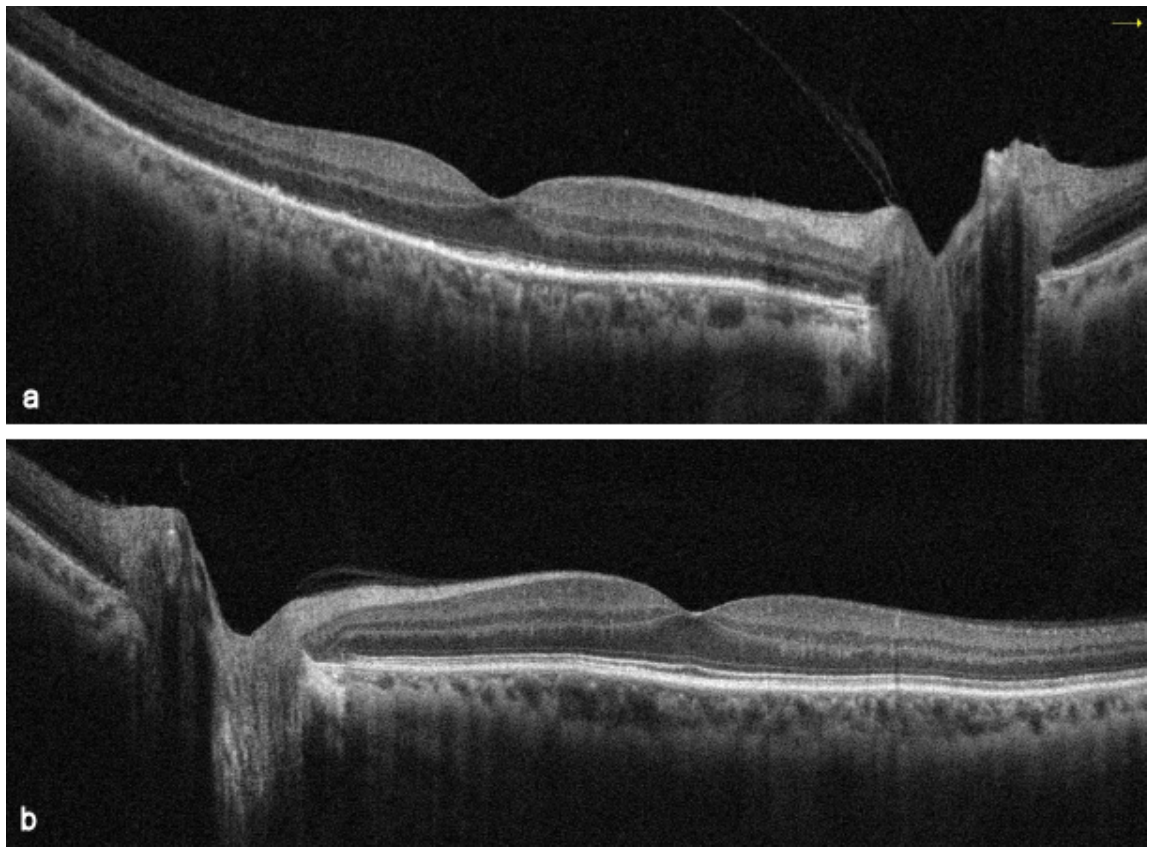
Figure 8: SD-OCT images at 2-week examination after the treatment (a) Marked recovery in EZ and outer segment of photoreceptors on SD-OCT images in the right eye, (b) SD-OCT image of the left